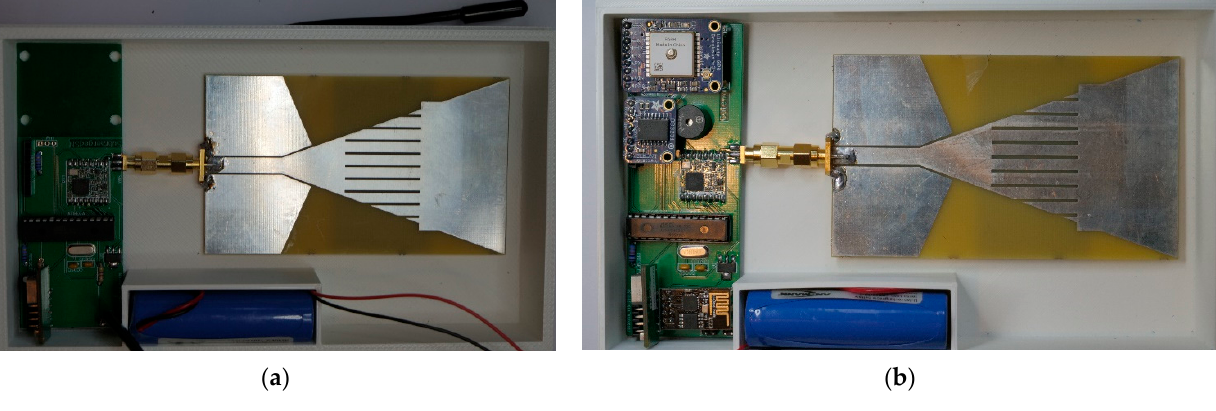
Figure 7. ( a ) Buoy sensor node ( b ) IoT gateway.